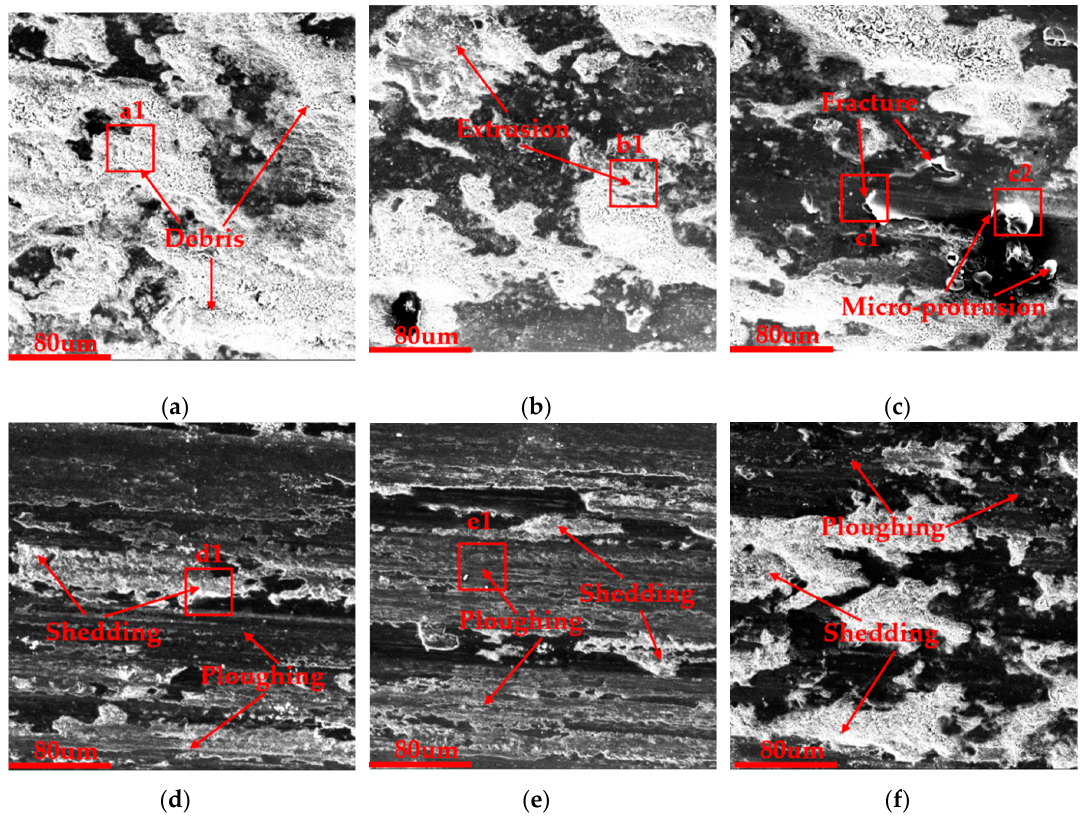
Figure 9. Wear scars morphology under SEM: ( a ) 0 HCT; ( b ) 3 HCT; ( c ) 6 HCT; and ( d ) 9 HCT; ( e ) 12 HCT; ( f ) 24 HCT.